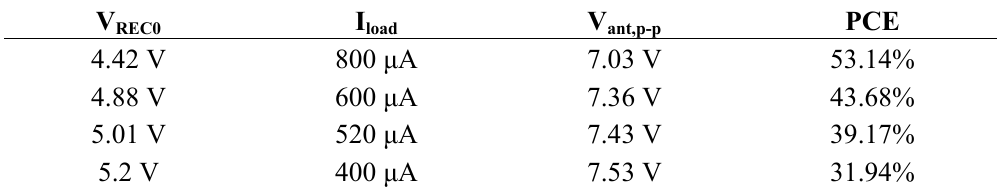
Table 2. Simulation results of PCE of RF powering circuit in HJTC 0.25 µm process.